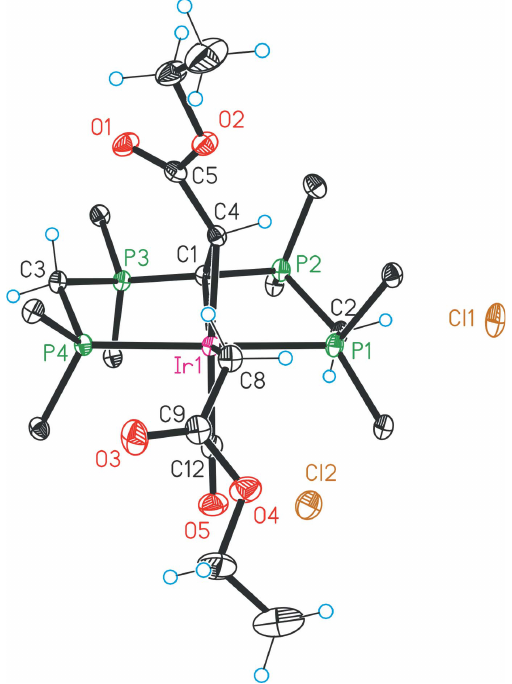
Figure 5 Molecular structure of the complex cation in 7 and the two counter-ions. Displacement ellipsoids are drawn at the 30% probability level. For clarity, only the ipso carbon atoms of the phenyl groups are presented and the solvent molecules are omitted.